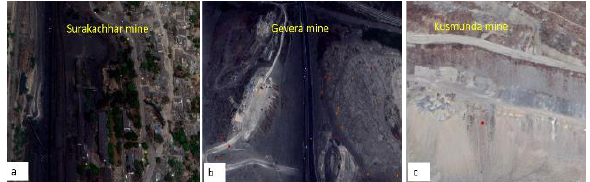
Figure 8 Coal mine areas of Korba zoomed view of deformation points (a) Surakachhar, (b) Gevera and (c)